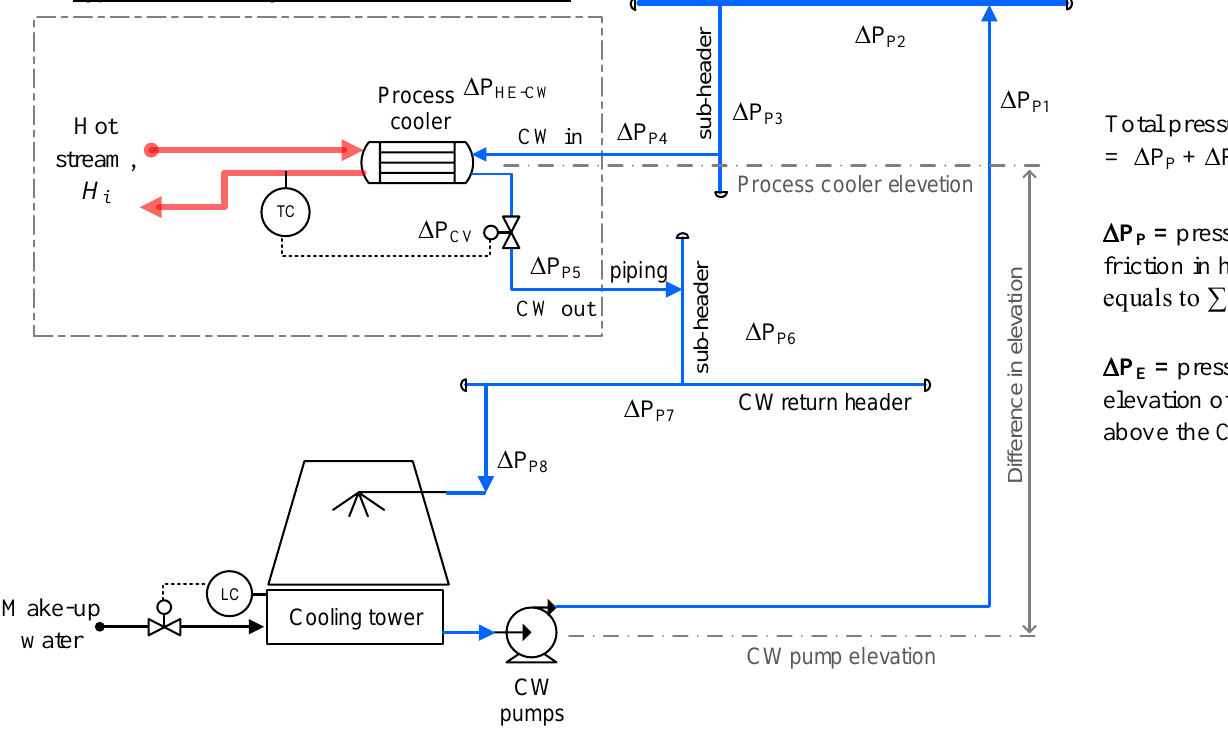
Figure 5. Process flow diagram—cooling water distribution